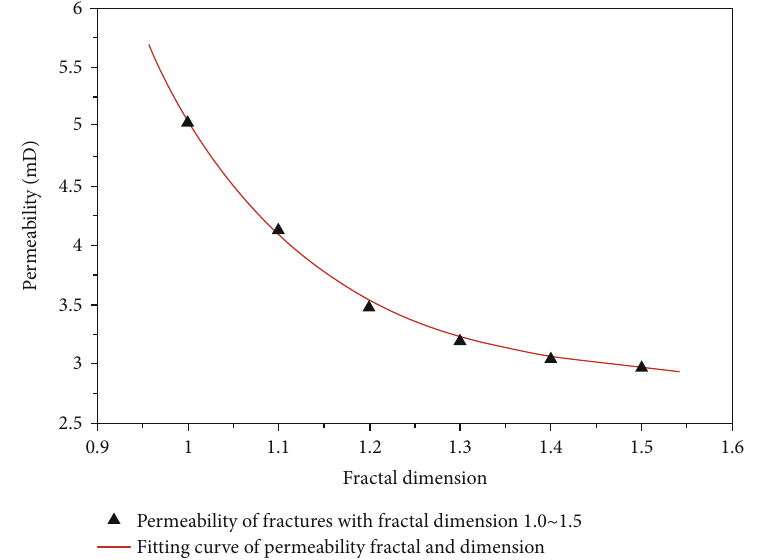
Figure 11: Fitting curve of permeability and fractal dimension.